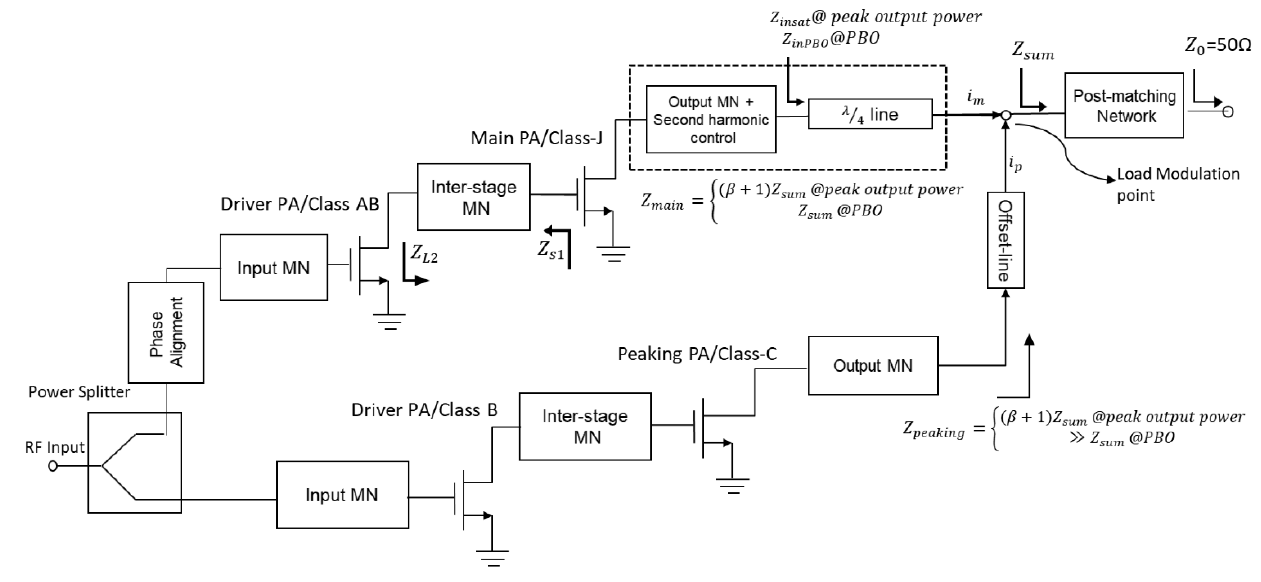
Figure 1. Schematic diagram of the proposed GaAs pHEMT DPA at K-band frequencies.